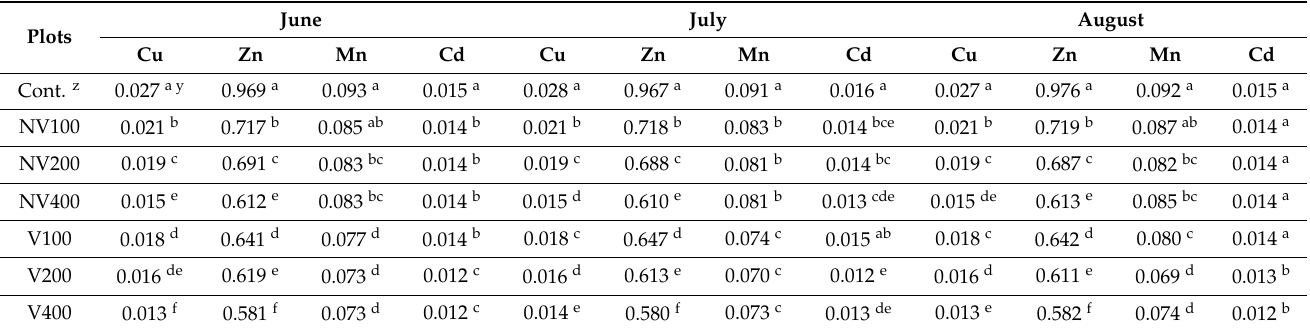
Table 3. Four heavy metals (Cu, Zn, Mn, and Cd) in runoff from different substrate depths and vegetation plots based on rainfall